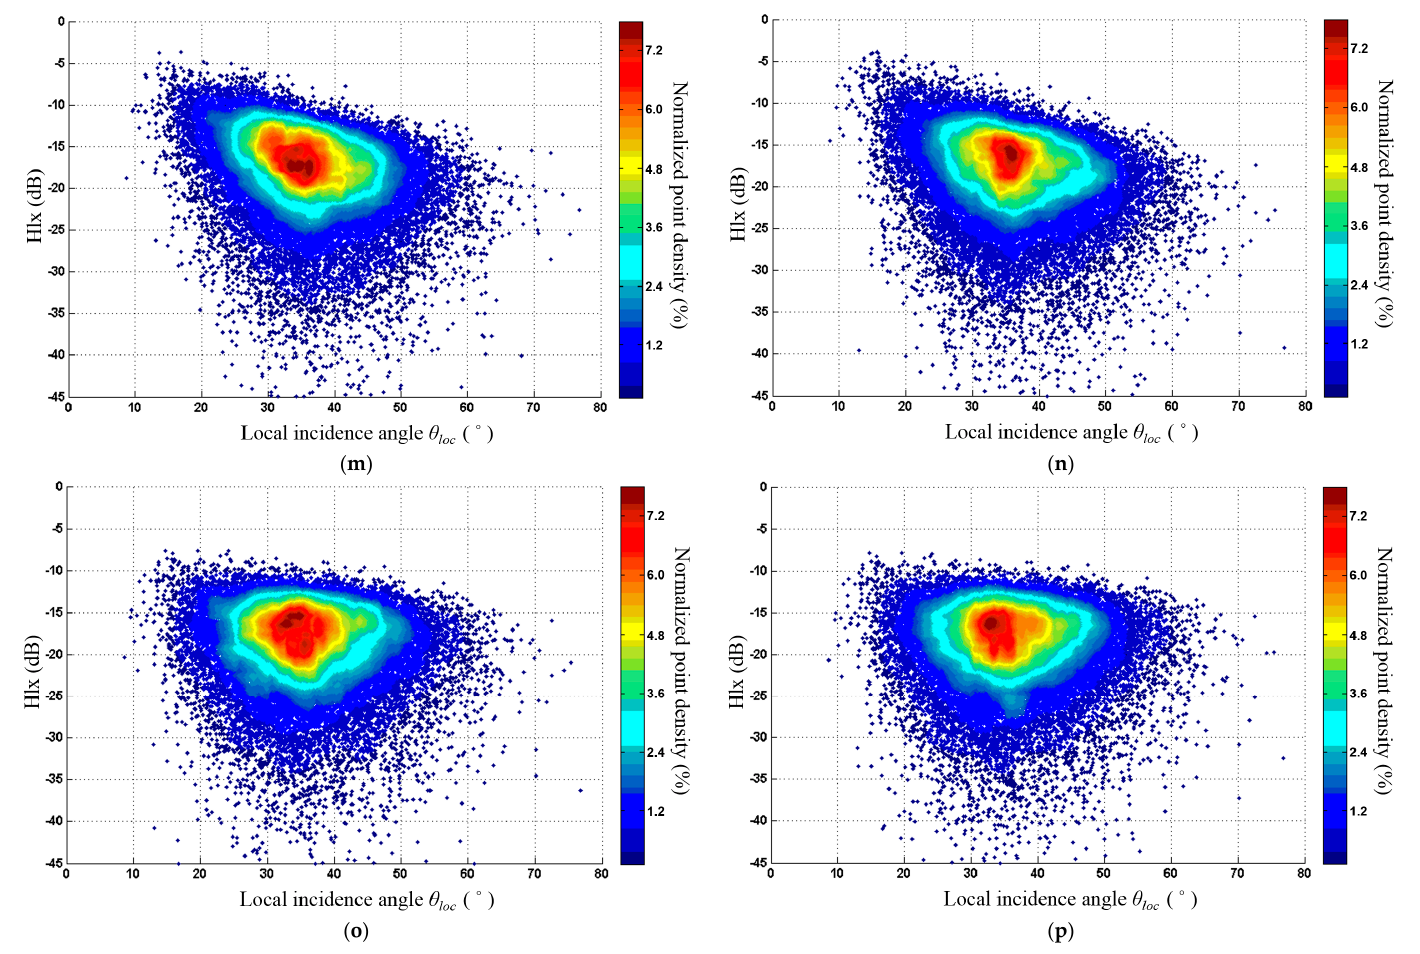
Figure 20. The relationship between decomposition parameters (Yamaguchi Four-Component Decomposition [22]) and local incidence angle. Odd: surface scattering power, Dbl: double-bounce scattering power, Vol: volume scattering power, Hlx: helix scattering power. ( a ) GTC Odd vs. θ loc ; ( b ) POA Odd vs. θ loc ; ( c ) POA + ESA Odd vs. θ loc ; ( d ) POA + ESA + ESV Odd vs. θ loc ; ( e ) GTC Dbl vs. θ loc ; ( f ) POA Dbl vs. θ loc ; ( g ) POA + ESA Dbl vs. θ loc ; ( h ) POA + ESA + ESV Dbl vs. θ loc ; ( i ) GTC Vol vs. θ loc ; ( j ) POA Vol vs. θ loc ; ( k ) POA + ESA Vol vs. θ loc ; ( l ) POA + ESA + ESV Vol vs. θ loc ; ( m ) GTC Hlx vs. θ loc ; ( n ) POA Hlx vs. θ loc ; ( o ) POA + ESA Hlx vs. θ loc ; ( p ) POA + ESA + ESV Hlx vs. θ loc .